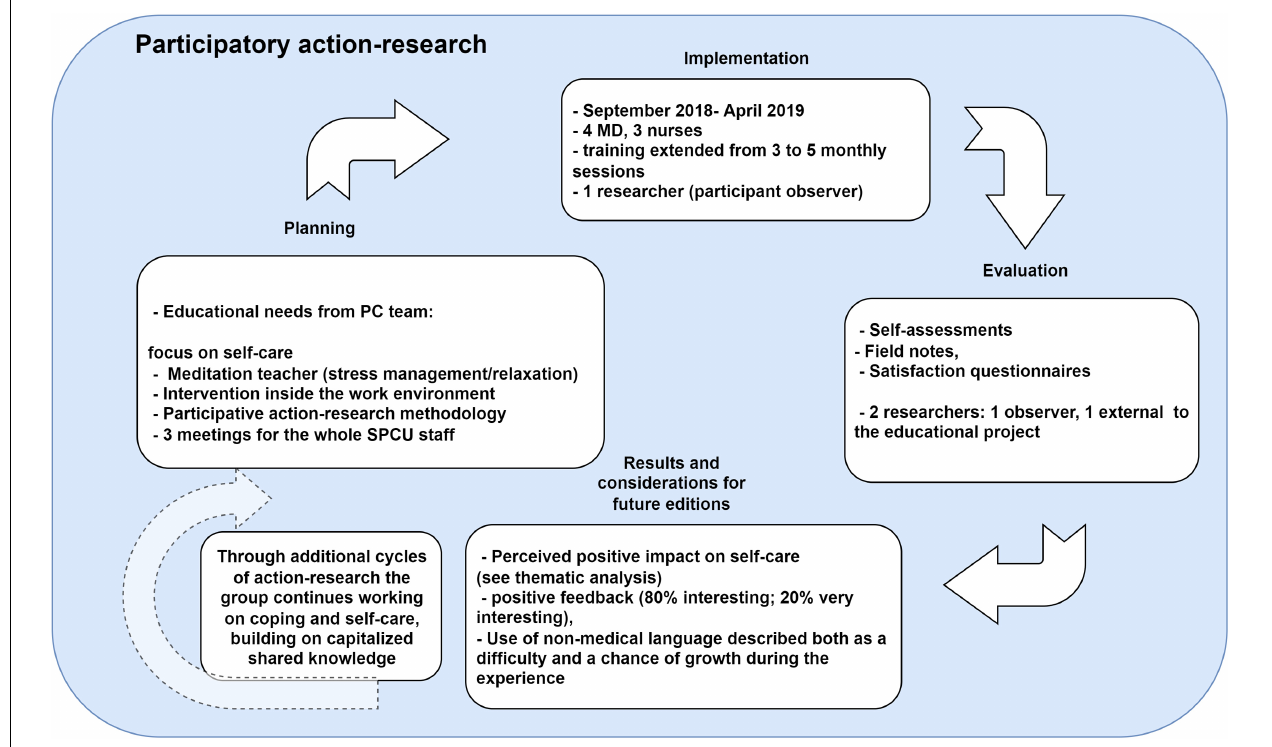
FIGURE 1 | The different phases of action research adapted to our